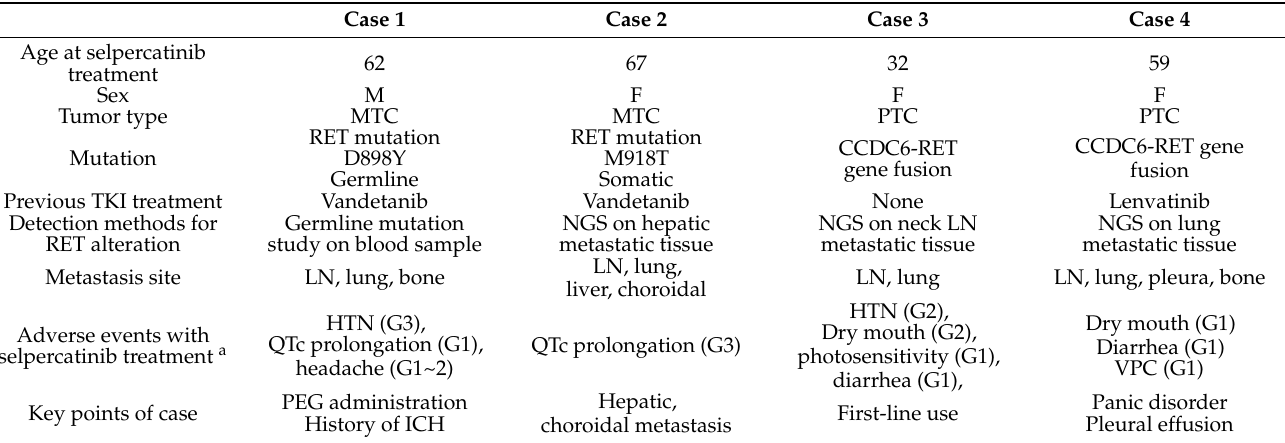
Table 1. Summary of